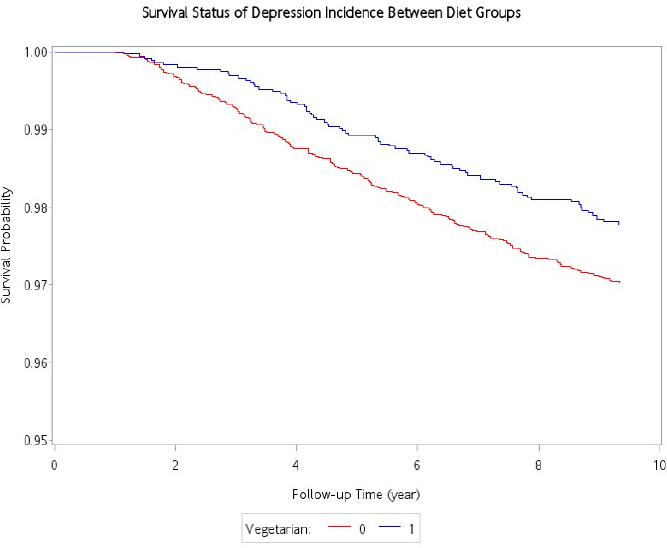
Figure 2. Cumulative incidence of depression for vegetarians and non-vegetarians. Table 2. Cox proportional hazard model for the risk of developing depressive disorders.